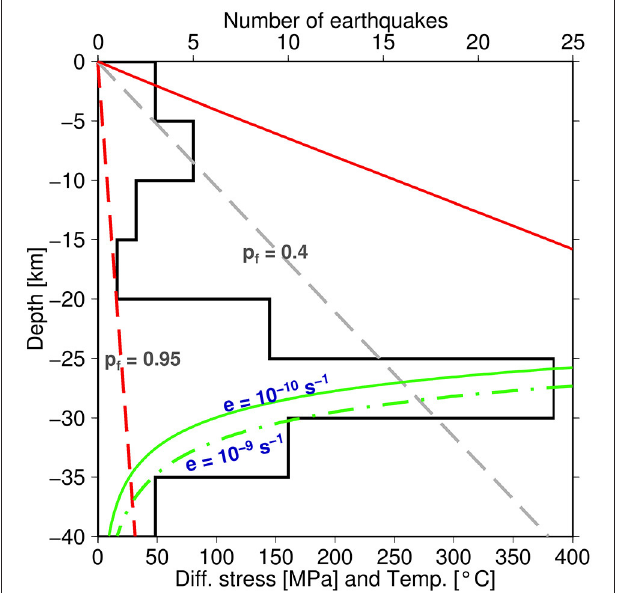
FIGURE 5 | Yield Strength Envelope (YSE) constructed using transient strain rate of 10 − 10 and 10 − 9 s − 1 (For the sake of clarity, we only show the curves for the lower crust). The stairs-step shows the depth distribution of earthquakes in the rift, similar to Figure 4D . This transient high pore fluid pressure and strain rate explains the observed lower crustal seismicity in the central MER (Lapins et al., 2020 ). The flow law and geothermal gradient are similar to Figure 4C .